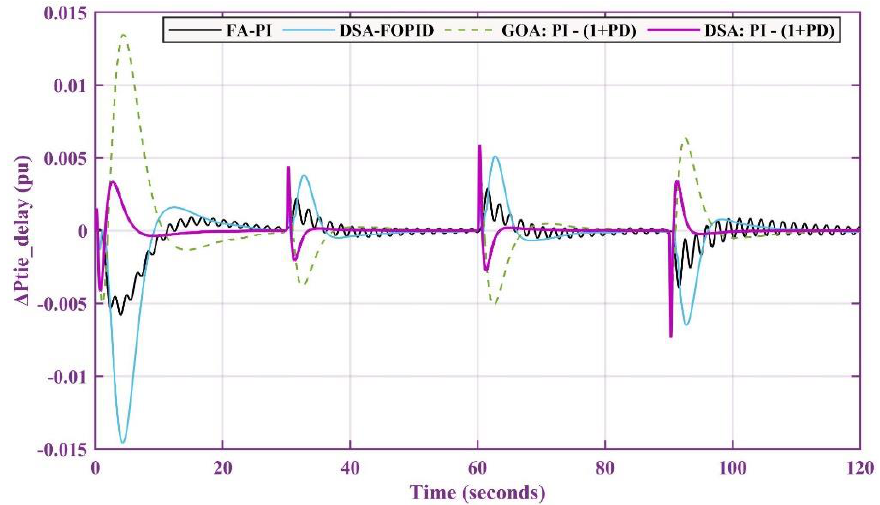
Figure 17. Area-2 response with communication delay.